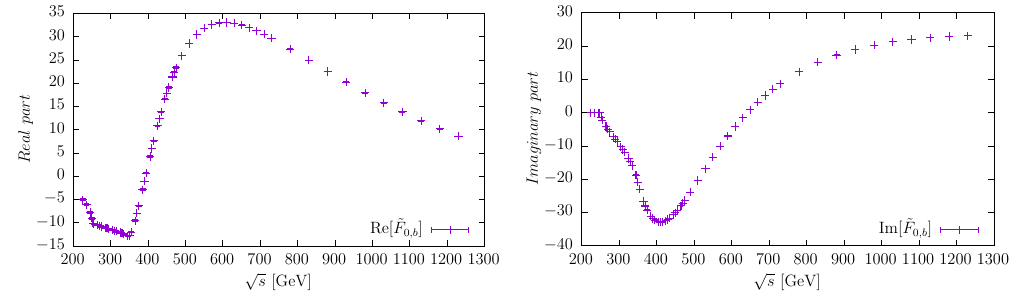
Figure 4 . The grid inputs for the real (left) and imaginary (right) parts of ~ F 0 ;b . tic coupling is an e(cid:11)ective coupling (cid:21) = (cid:0) 2 (cid:21) 2 =m 2 . The factor of 2 originates from the 4 3 X number of diagrams contributing to the double-box amplitude, which is twice the number of diagrams contributing to the box-triangle